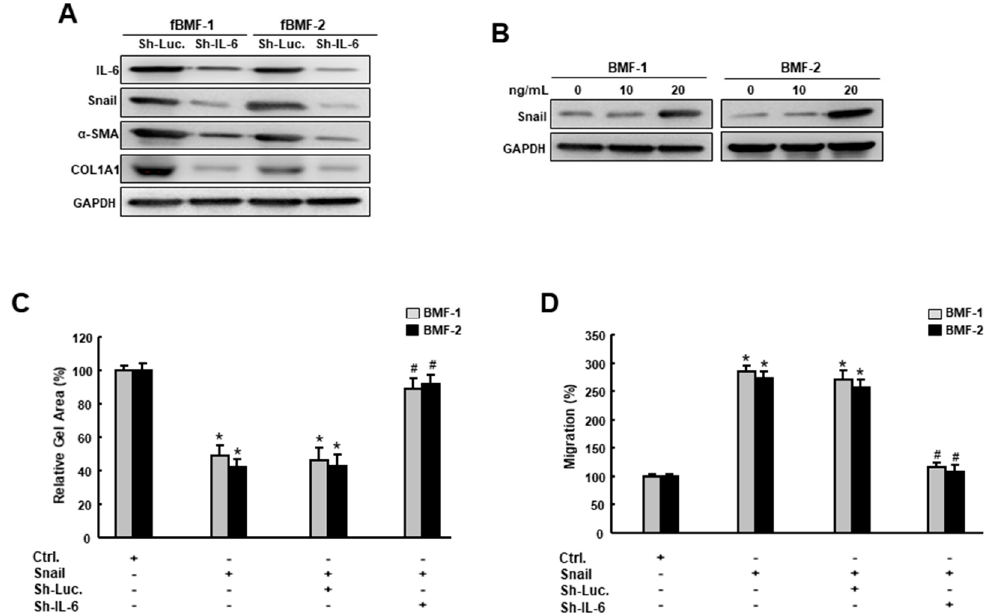
Figure 6. IL-6 is essential to the Snail-induced myofibroblasts’ features. ( A ) Protein expression of IL-6, Snail, α -SMA and type I collagen in fBMFs transduced with sh-Luc or sh-IL-6; ( B ) Protein expression of Snail in BMFs treated with various concentrations of IL-6; ( C ) Collagen gel contractility and ( D ) migration capacity in BMFs with an overexpression of Snail with sh-Luc or sh-IL-6. Results are means ± SD of triplicate samples from three experiments. * p < 0.05 compared to ctrl. group. # p < 0.05 compared to Sh-Luc +Snail group.